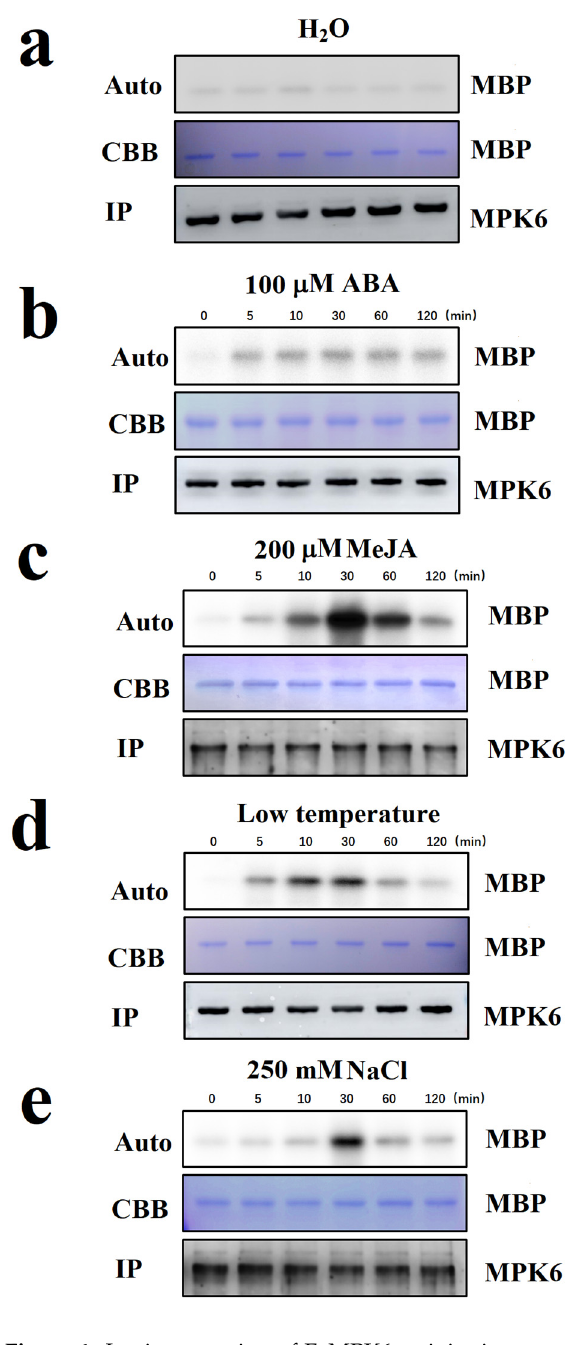
Figure 4. In vivo assaying of FaMPK6 activity in response to different stimuli. Detached fruit at the LG stage were transiently transformed with A. tumefaciens carrying a FaMPK6: eGFP fusion construct driven by the pSuper promoter. On the 4th day after transformation, fruits were treated, and then proteins were and the FaMPK6: GFP fusion protein was immunoprecipitated using an anti-GFP antibody. The in vitro kinase activity of FaMPK6 was measured using 32 P-ATP and MBP as substrates. ( a ) control, water treatment; ( b ) 100 µ M abscisic acid (ABA) treatment; ( c ) 200 µ M methyl jasmonate (MeJA) treatment; ( d ) low temperature (4 ◦ C); ( e ) high salt (250 mM NaCl) treatment.